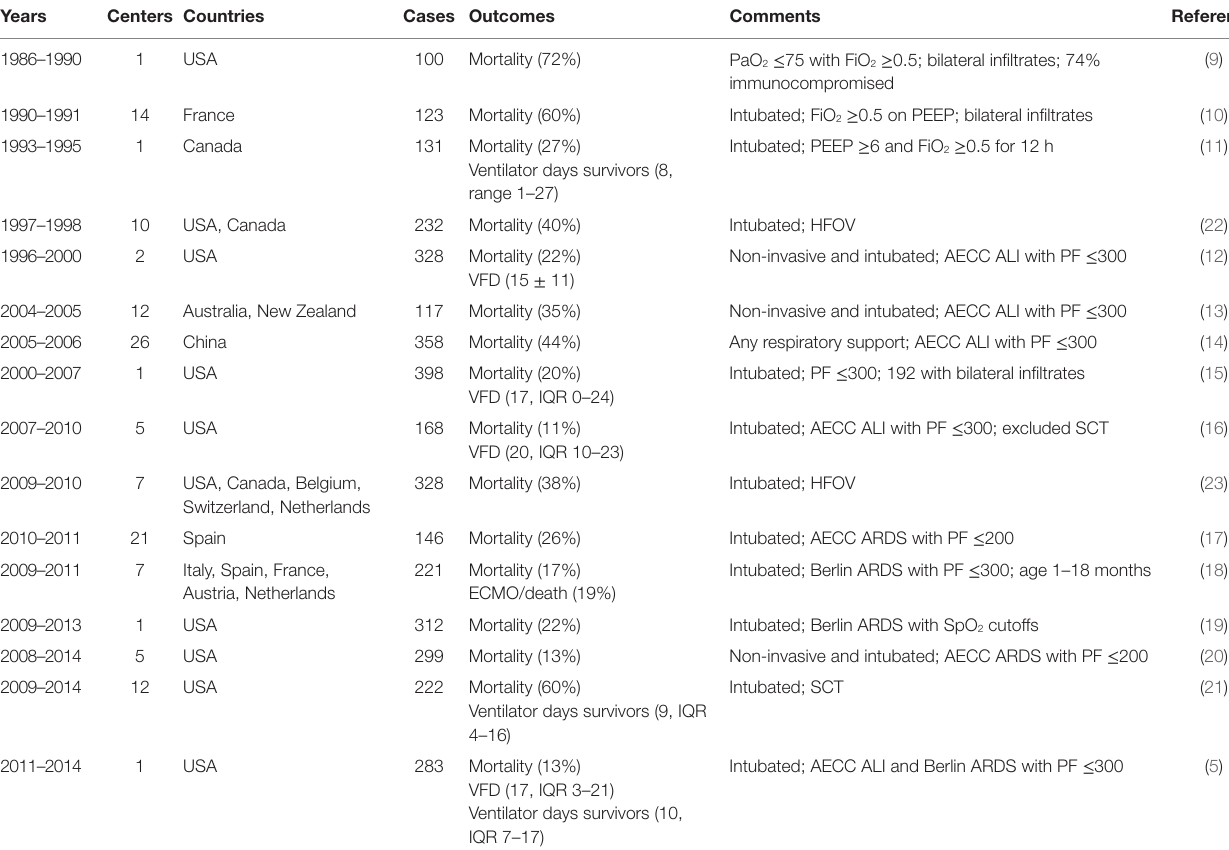
TABLe 1 | Reported outcomes in cohorts using PARDS-type inclusion criteria and ≥ 100